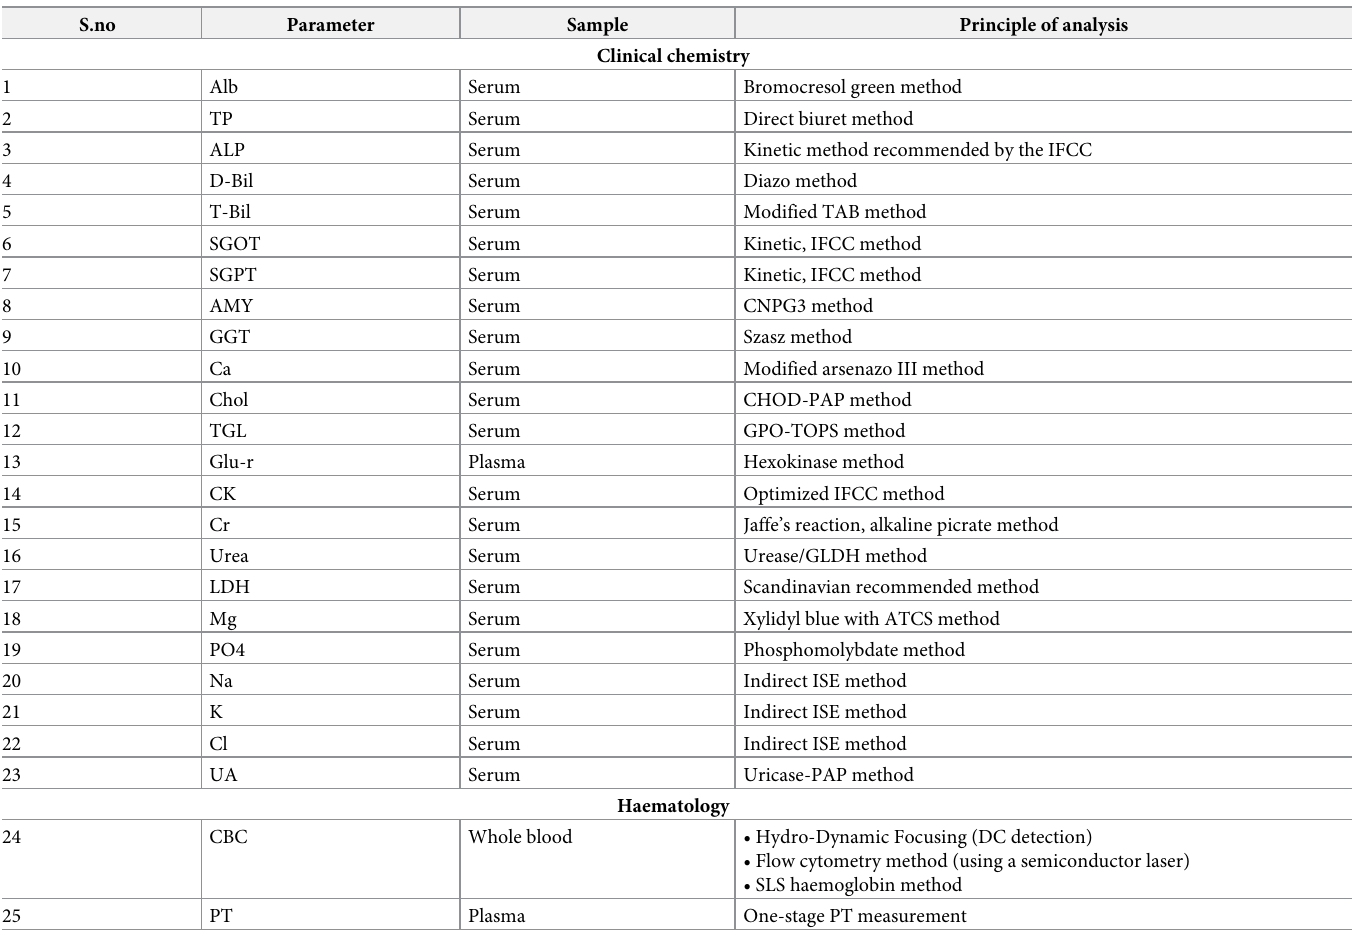
Table 2. The sample used and the principle of analysis of test